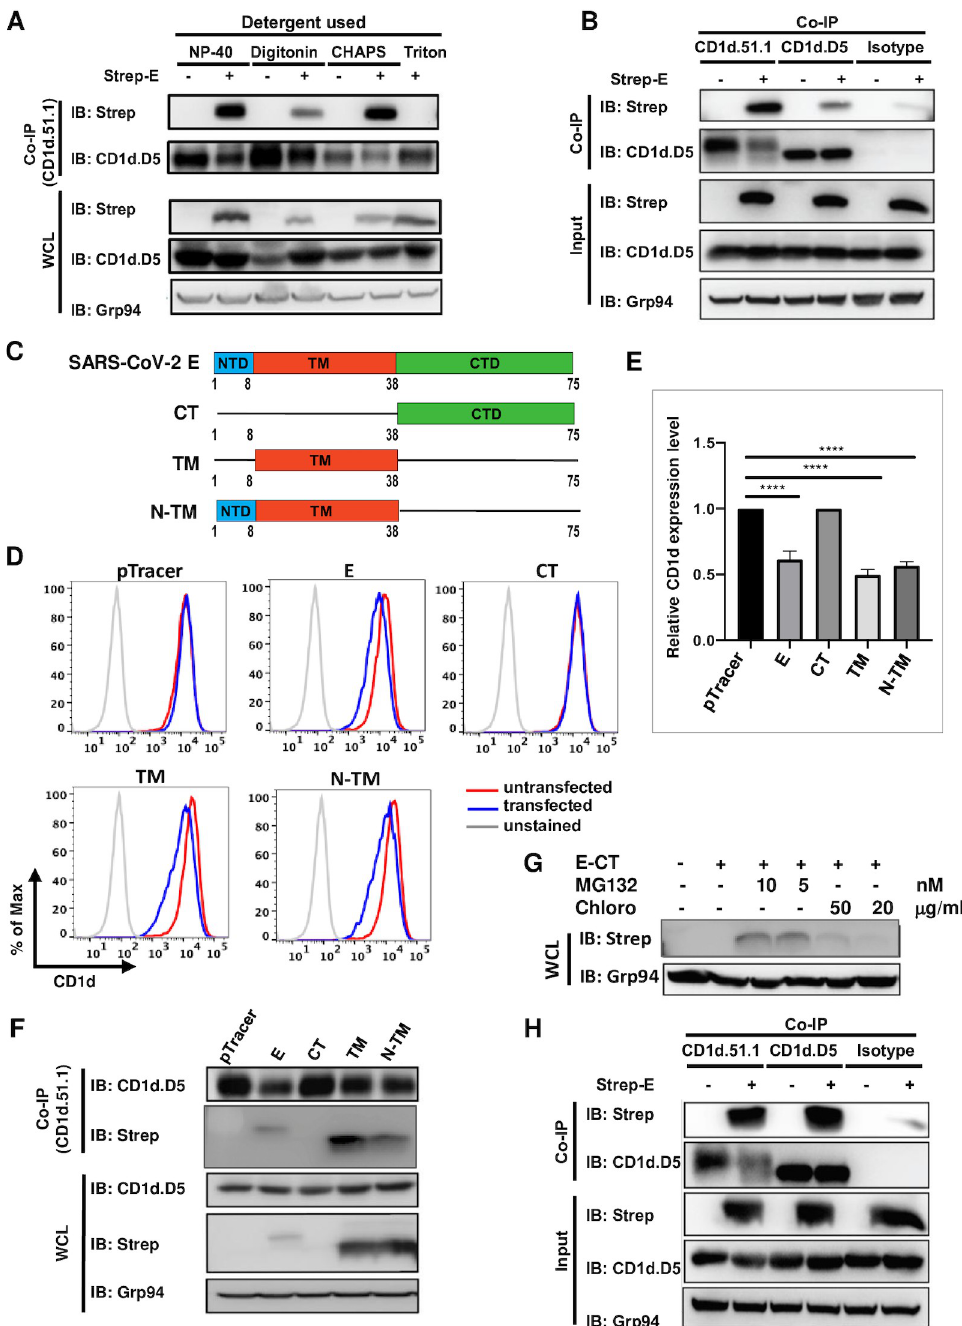
Fig 4. SARS-CoV-2 E protein specifically interacts with mature form of CD1d and leads to its degradation. (A). 293T.CD1d cells were transfected to express Strep-tagged E protein, lysed in 1% indicated detergents and subjected to immunoprecipitation with a mature form-specific anti-CD1d antibody, CD1d.51.1. Immunoprecipitated proteins were western blotted for CD1d and E protein with anti-CD1d antibody (CD1d.D5) or anti-Strep antibody, respectively. Whole cell lysate (WCL) was also blotted by anti-CD1d (CD1d.D5), anti-Strep and anti-Grp94 antibodies. (B). 293T. CD1d cells were transfected to express Strep-tagged E protein and lysed in 1% CHAPS. The cell lysates were immunoprecipitated with either anti-CD1d antibodies (CD1d.51.1 or CD1d.D5, specific for mature or immature-form CD1d, respectively) or an isotype control monoclonal antibody (IgG2b). Immunoprecipitated proteins and whole cell lysates were western blotted with indicated antibodies. Equivalent amounts of whole cell lysate input in coimmunoprecipitations (Input) were loaded and blotted with antibodies against Strep tag, CD1d (CD1d.D5) or ER